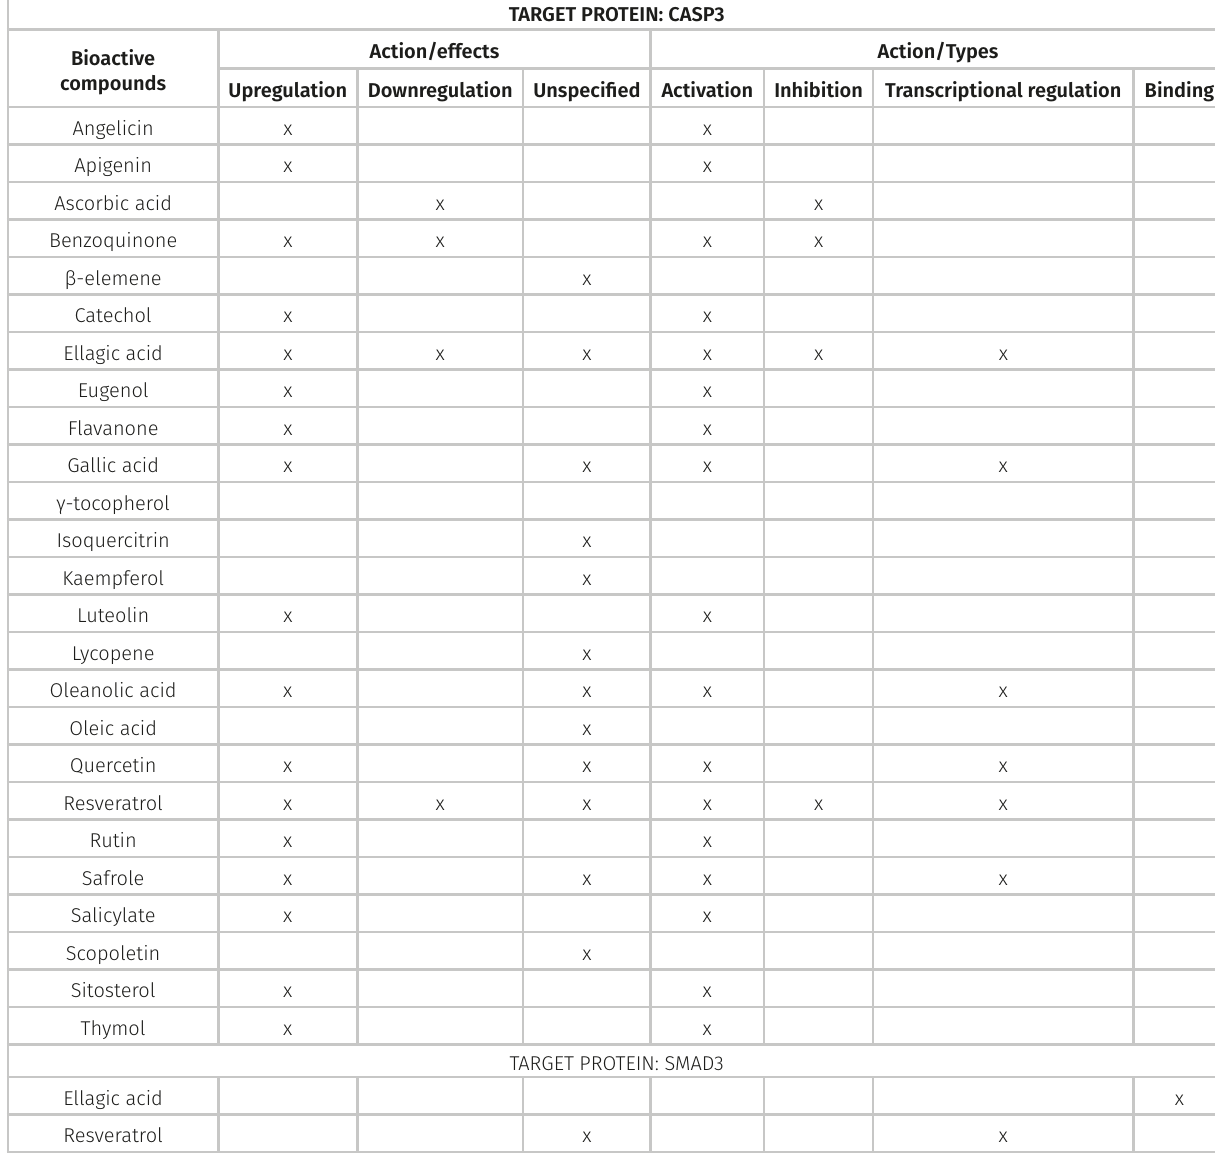
Table I. Effects of bioactive compounds from Brazilian plants on the CASP3 and SMAD3 target